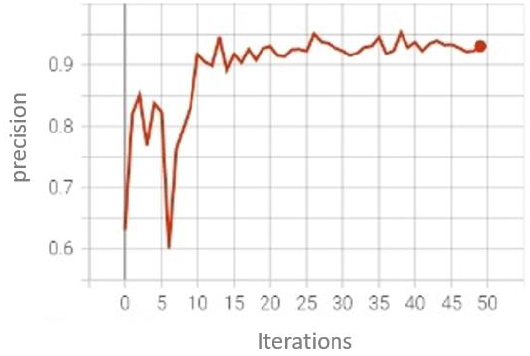
Figure 18. License plate detection training graph.